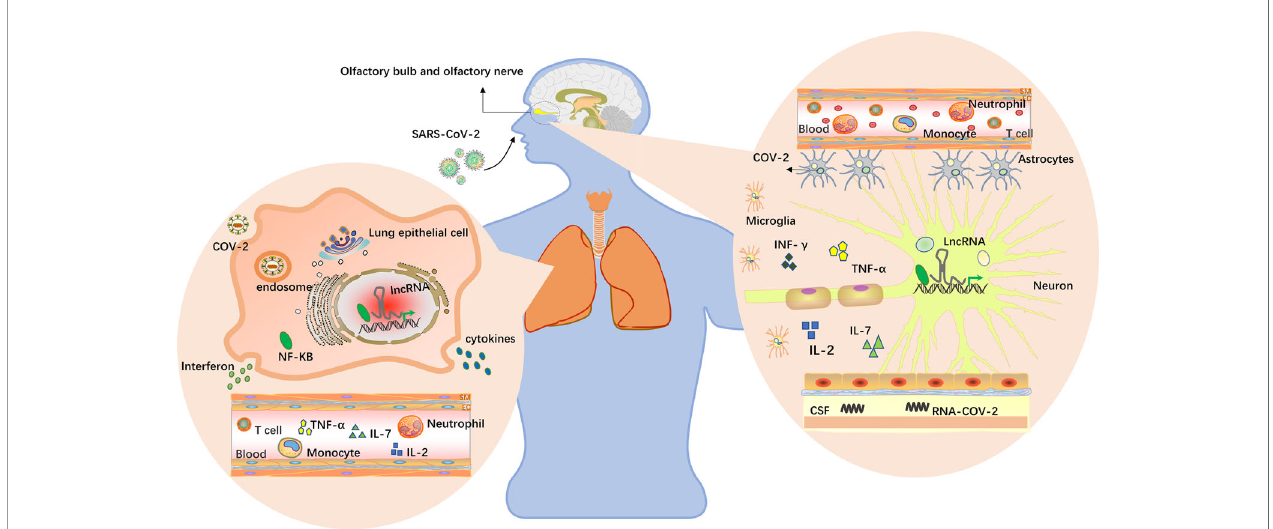
FIGURE 2 | LncRNAs in the brain and lungs. The virus enters the body through the nose and mouth, causing pneumonia and other symptoms. Upon oral infection, the virus reaches the lungs and, from there, can spread into the CNS by the hematogenous route. Upon nasal infection, SARS-CoV-2 can reach the CNS through the olfactory bulb (89). Viruses have been detected in the CSFs of infected patients, and in fl ammation in the brain has been described. Multiple studies have found that lncRNAs are differentially expressed in humans, and lncRNAs near the alveoli and olfactory bulb may be induced by viruses to participate in speci fi c cellular activities in this region, including virus infection, replication, latent infection and immune responses. Cytokine storms occur when the immune system is overactivated, causing a surge in interleukin-2, IL-7, interferon- g and tumor necrosis factor expression (64,